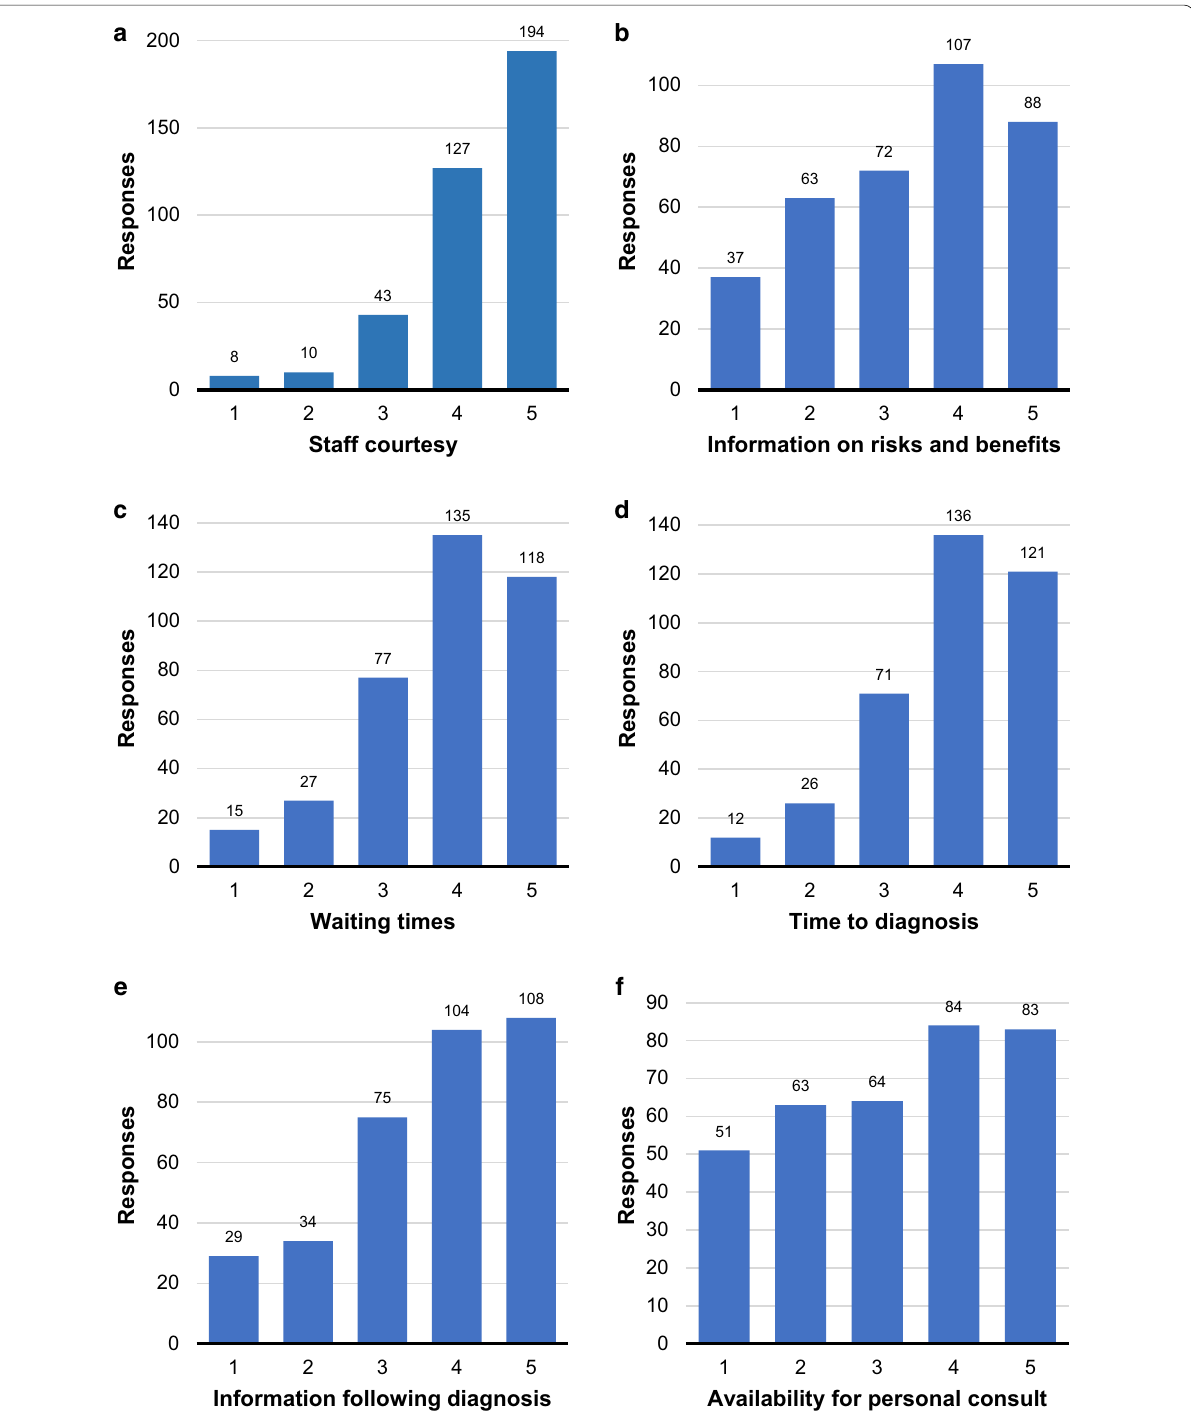
Fig. 9 Rating of the following aspects of the radiology service: a Courtesy of the staff. b Information provided about benefits & risks of the procedure. c Waiting times (i.e. from referral to appointment). d Time-to-diagnosis (from initial referral). e Information provided by radiology staff following diagnosis. f Availability of the radiologist for personal consultation. (1